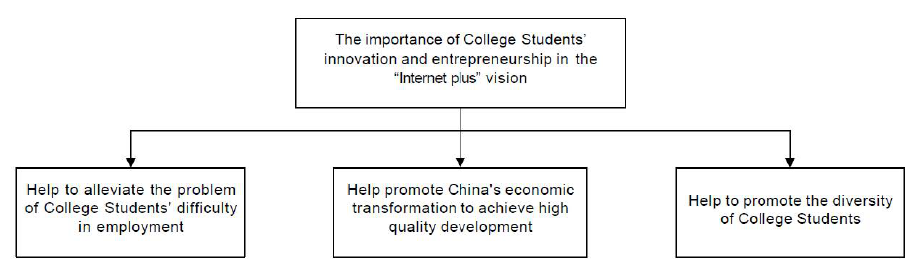
Fig. 1 The importance of innovation and entrepreneurship among college